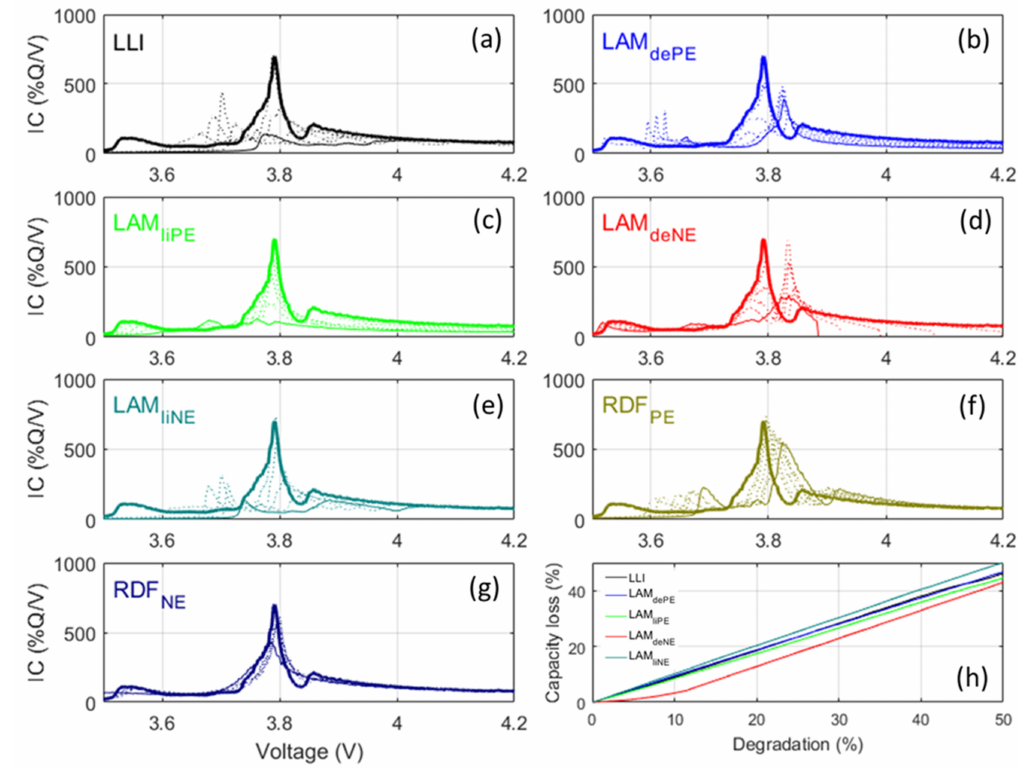
Figure 10. Degradation table for the selected cell with the IC curves associated with up to 50% of ( a ) LLI; ( b ) LAM dePE ; ( c ) LAM liPE ; ( d ) LAM deNE ; and ( e ) LAM liNE . IC curves associated with up to 10 × kinetic hindrance for ( f ) RDF PE and ( g ) RDF NE and ( h ) Capacity loss associated with ( a – e ). Thick solid line represents the initial signature, thin solid line the final signature and dashed line the